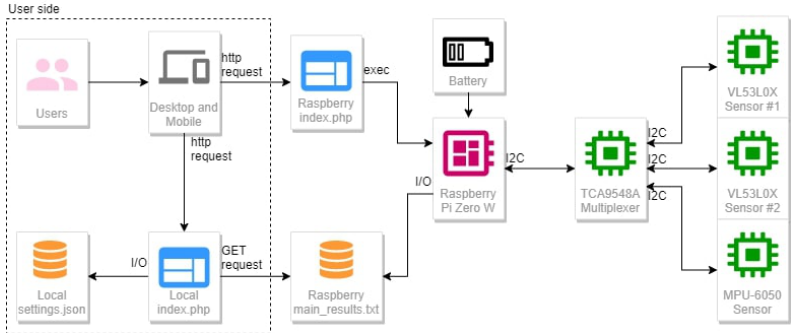
Figure 1. An overview of the system’s software and hardware